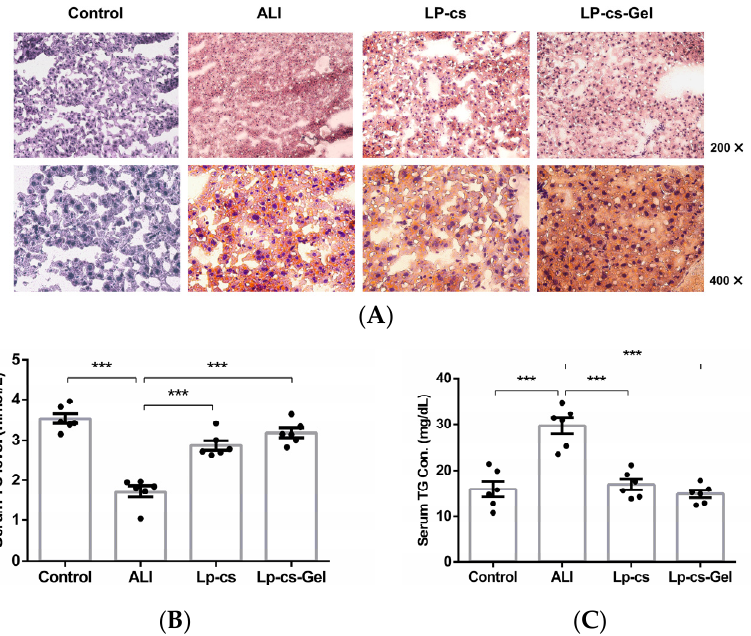
Figure 6. Assessment of lipid metabolism at the tissue and serum levels: ( A ) Liver tissues stained by Oil red O in each group of mice (200 × and 400 × ); ( B ) serum TC levels in each group of mice, which were 3.53 ± 0.12, 1.72 ± 0.14, 2.88 ± 0.12, and 3.18 ± 0.11 mmol/L in the control, ALI, LP- cs, and LP-cs-Gel-presupplemented groups, respectively; ( C ) serum TG levels in the control, ALI, LP-cs, and LP-cs-Gel-presupplemented groups, which were 15.87 ± 1.67, 29.71 ± 1.78, 16.89 ± 1.19, and 14.81 ± 0.81 mg/dL, respectively. Data are presented as individual data points as well as the mean ± SEM for each group, with n = 6 per group. P -values were determined by one-way ANOVA. *** p < 0.001.